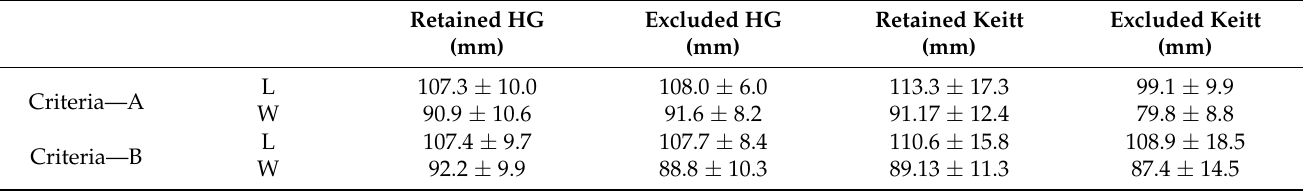
Table 7. Mean ± SD of calliper length measurements for populations retained and excluded on the basis of criteria to identify occluded fruit for Method 2, Criteria A and B. Units are in mm. Retained